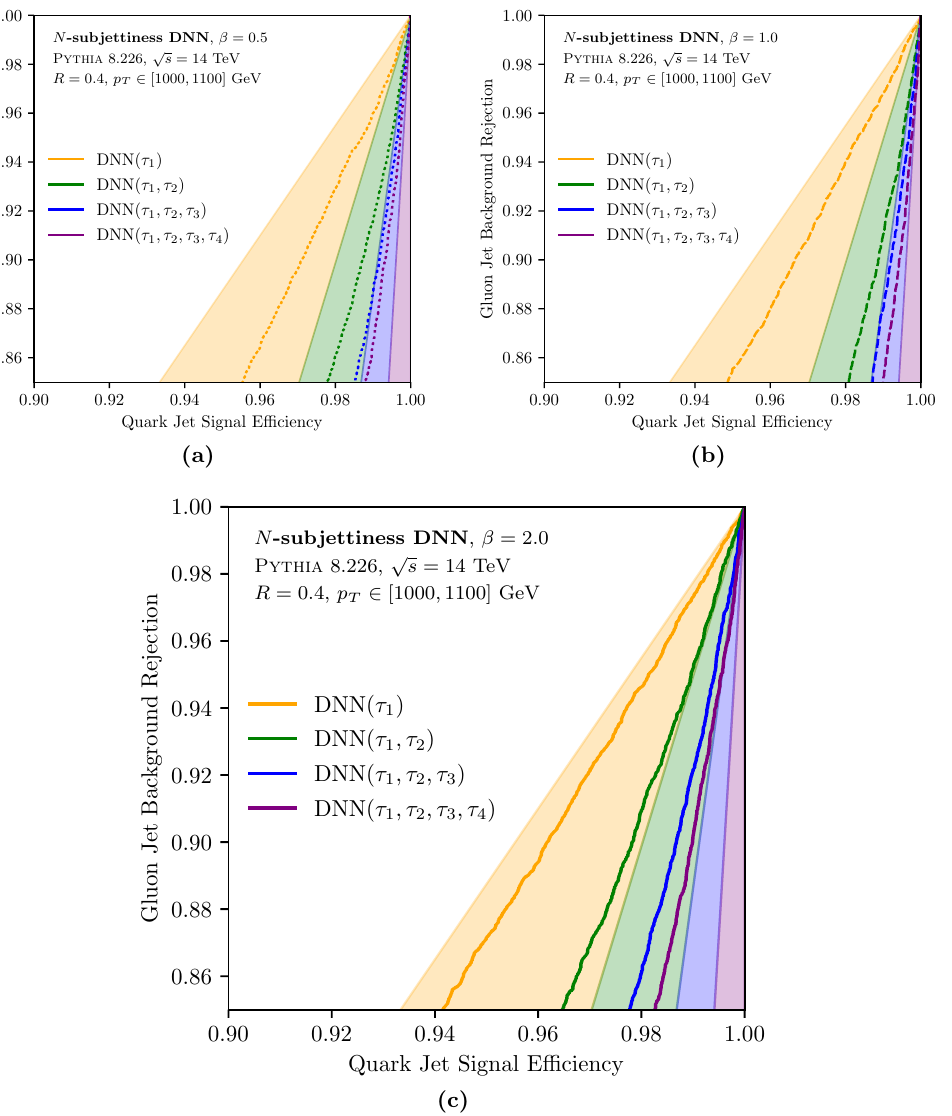
Figure 17. ROC curves for neural networks trained on collections of multiple N -subjettiness observables for (a) (cid:12) = 0 : 5, (b) (cid:12) = 1 : 0, and (c) (cid:12) = 2 : 0, focused on the high quark e(cid:14)ciency region. The theoretical ROC bounds from (cid:20) g = ( C F =C A ) N for those collections of observables are shown as the shaded regions. We see that the bounds are indeed near saturated for (cid:12) = 2 : 0 with the best perturbative control. Higher order e(cid:11)ects increase the performance of lower (cid:12) values, though the hierarchy of performance